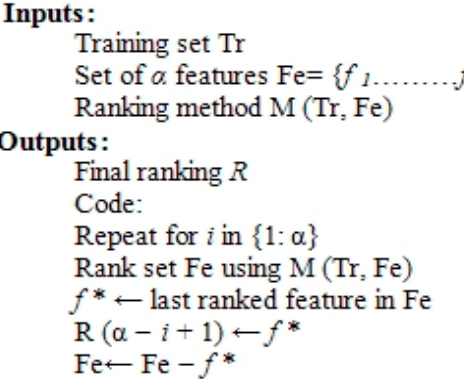
Figure 2. Summarized random forest recursive feature elimination (RF-RFE) algorithm.